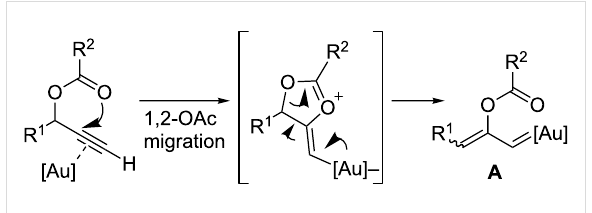
Figure 1: Gold-promoted 1,2-acyloxy migration on propargylic